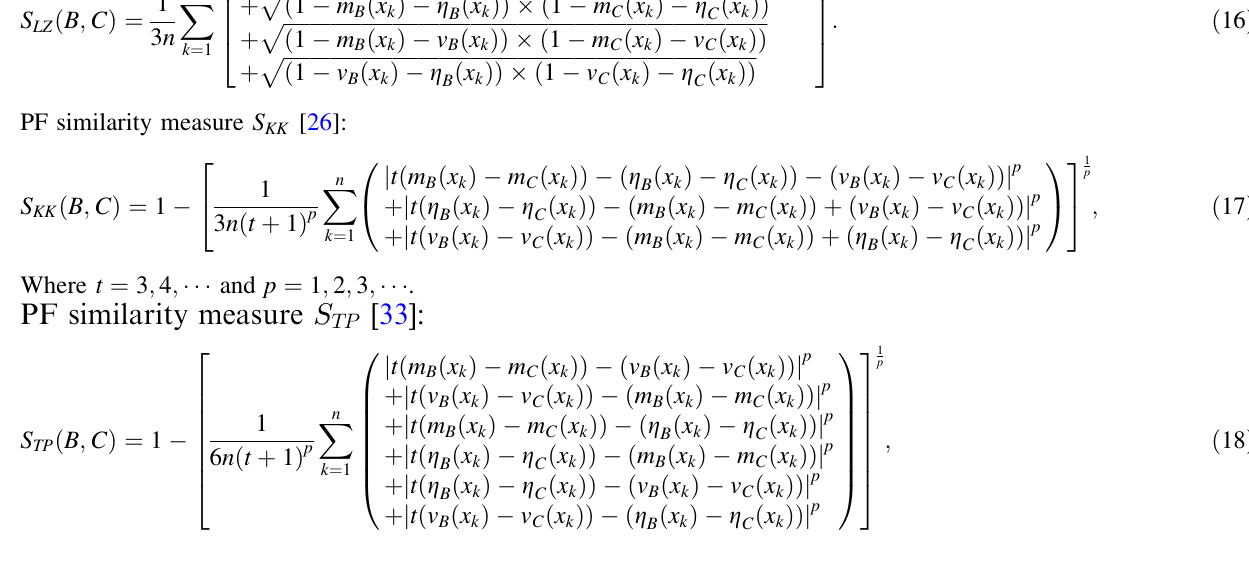
p ffiffiffiffiffiffiffiffiffiffiffiffiffiffiffiffiffiffiffiffiffiffiffiffiffi x k ð Þ g x k ð Þ v B x k ð Þ v C x k ð Þ g þ 2 B C